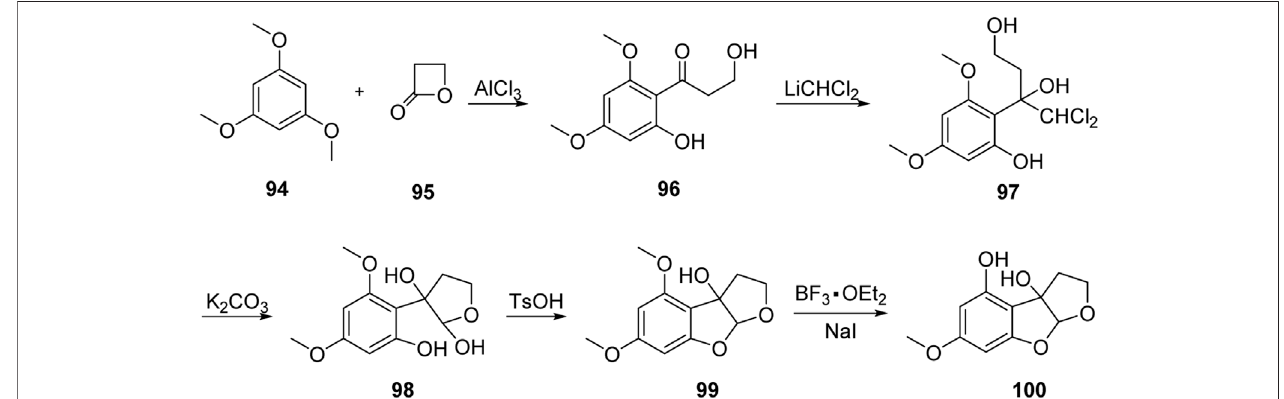
FIGURE 11 | Formal total synthesis of a fl atoxin M